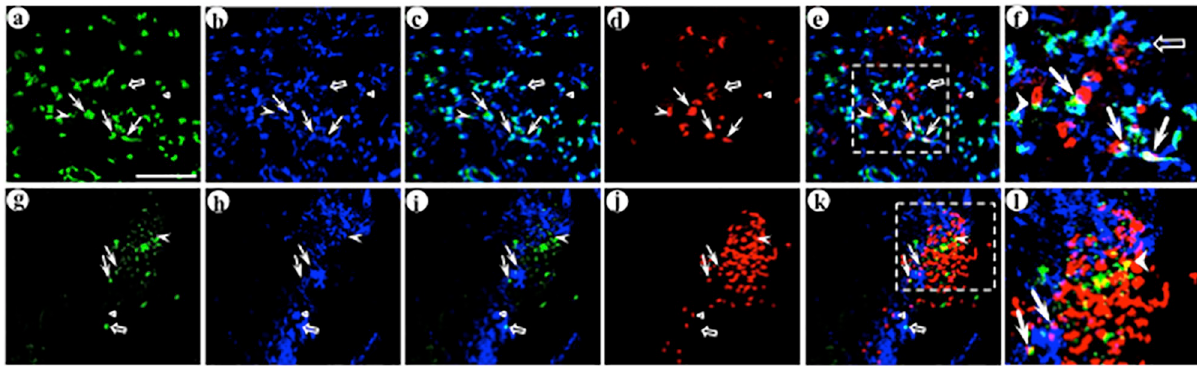
Fig 9. The synthetic peptide neurotransmitter dcv-secretogranin/anti-GABA A ß2or3-HtoL/his-tag supports gene transfer to the calretinin- containing subtype of GABAergic neurons. The experimental design and immunofluorescent costaining were as above, but calretinin-IR was assayed instead of parvalbumin-IR. (A-F) Image stacks show neuronal morphology for the transduced postsynaptic dendrites and cell bodies, proximal to transduced axons; (A) His tag-IR (fluorescein-conjugated secondary antibody), (B) GFP-IR (Alexa Fluor 633-conjugated secondary antibody), (C) merge of His tag-IR and GFP-IR, (D) calretinin-IR (TRITC-conjugated secondary antibody), (E) merge of all three IR, (F) merge, an enlarged area showing adjacent transduced axons and dendrites that contain calretinin-IR. Arrows, transduced axons proximal to transduced dendrites, with calretinin-IR. Open arrow, a transduced axon proximal to a transduced dendrite that lacks calretinin-IR. Arrowheads, transduced axons distant from transduced dendrites, but proximal to calretinin-IR. Open triangle, a transduced dendrite that contains calretinin-IR, but distant from a transduced axon. (G-L) Single confocal images in each channel show that delivery of this presynaptic vector, followed by the targeted postsynaptic vector, supported gene transfer across GABA A ß2- or ß3-containing synapses to calretinin-containing postsynaptic neurons; (G) His tag-IR, (H) GFP-IR, (I) merge of His tag-IR and GFP-IR, (J) calretinin-IR, (K) merge of all three IR, (L) merge, an enlarged area showing adjacent transduced axons and dendrites that contain calretinin-IR. Panels G-L show a different field than for panels A-F. Scale bar: 20 μ